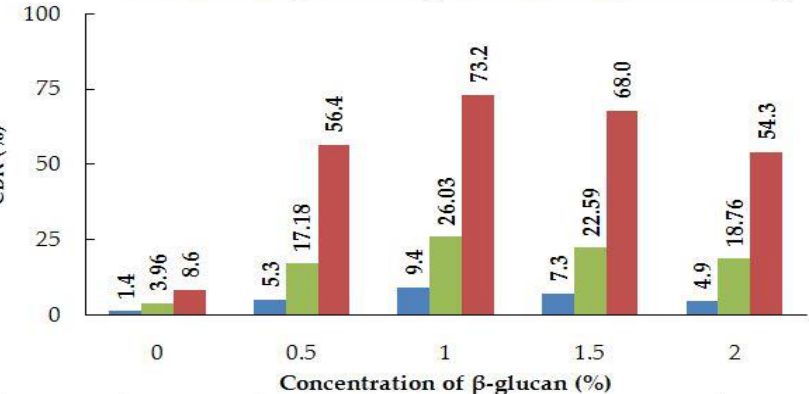
Figure 6. CBR of unsoaked, thermally cured, and thermally cured and soaked samples for untreated and β -glucan-treated kaolin.